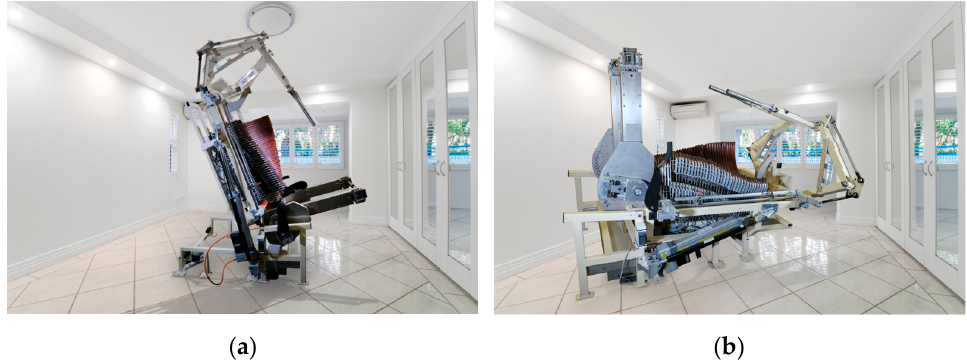
Figure 1. Dynamic spine correction (DSC) device; ( a ) the starting position and ( b ) a working position.